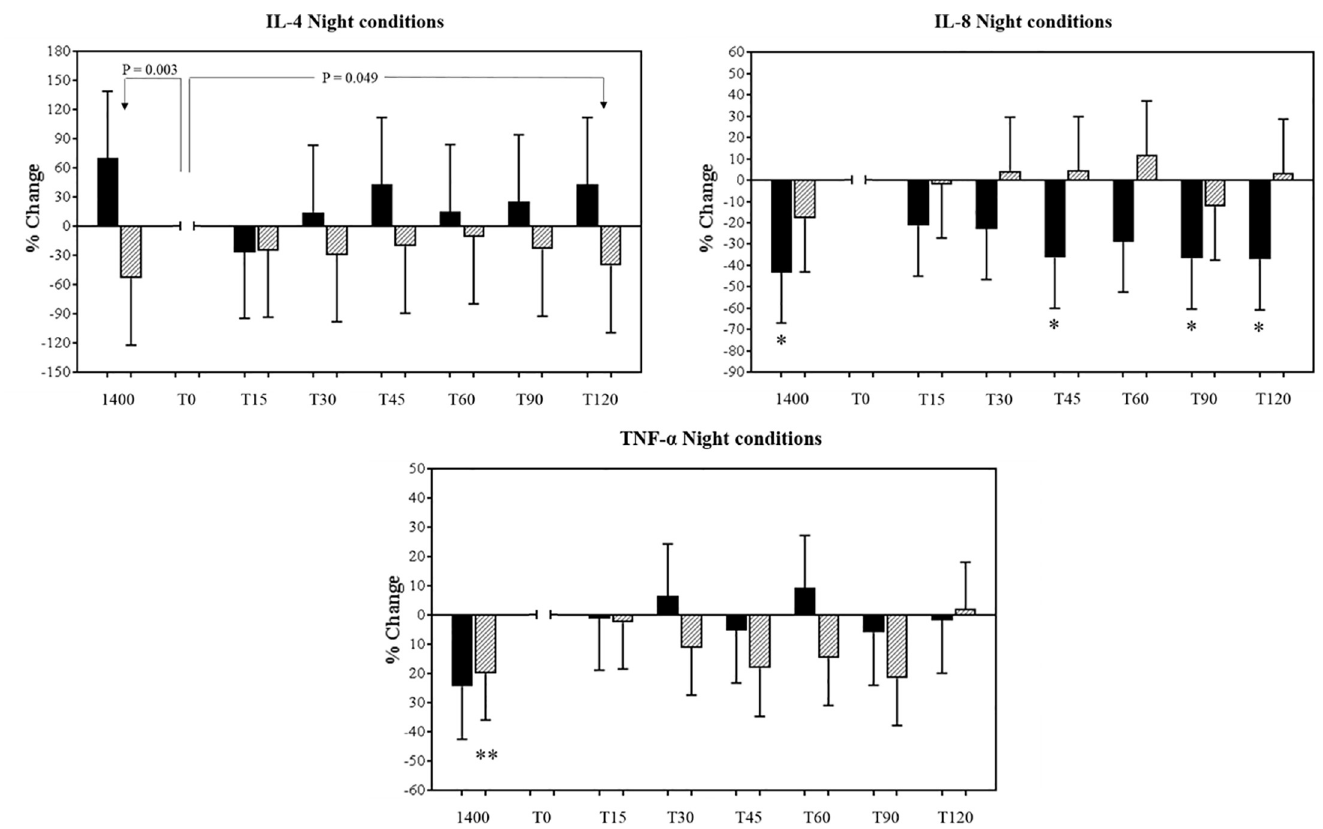
Fig 2. Mean ( ± SEM) percentage changes in Interleuklin-8 (IL-8), Interleuklin-4 (IL-4) and tumor necrosis factor alpha (TNF- α ) log-transformed plasma concentrations during 2-h of physiological sampling following a night alarm mobilisation, relative to T0 for each condition, time matched to control conditions. Dark bars (night alarm), light bars (night inactive). � P < 0.05, �� P < 0.010 within-condition change relative to T0, and between-condition changes relative to T0 (denoted by line and P-value).